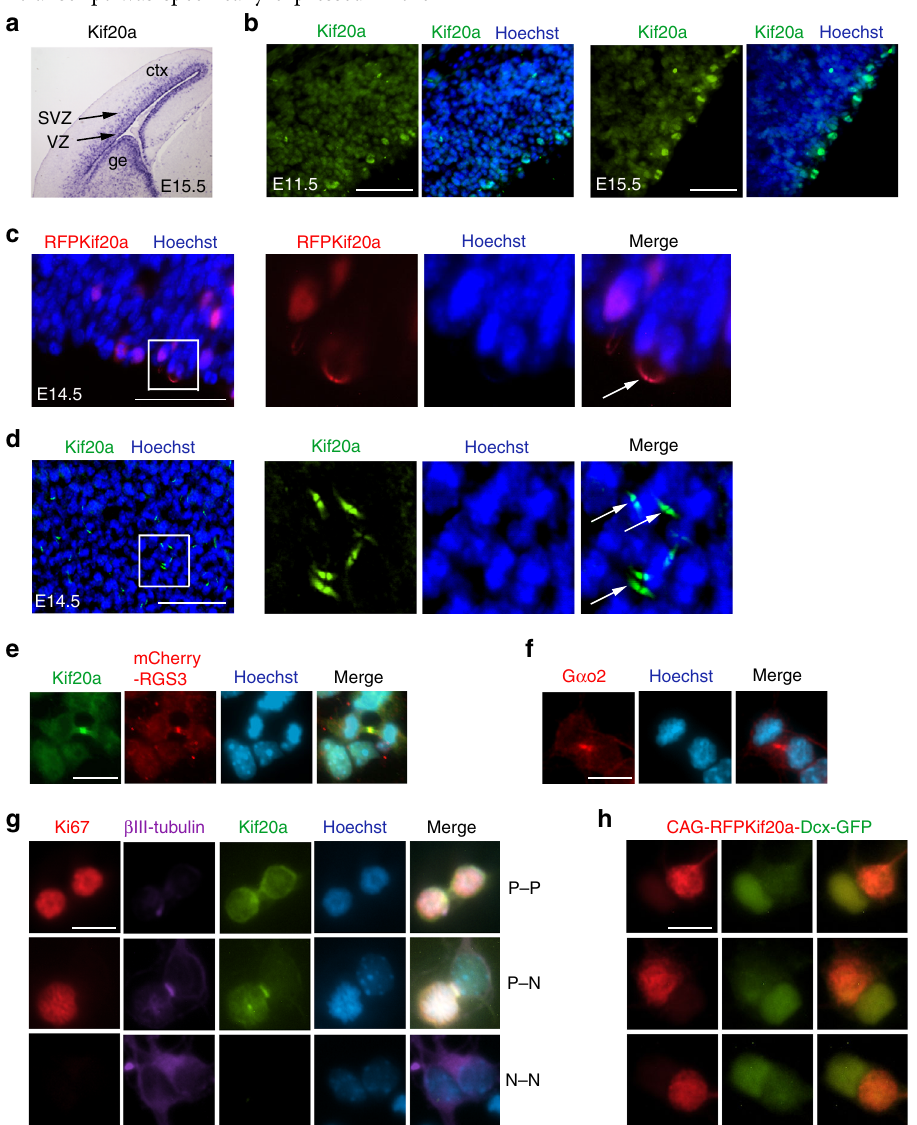
Fig. 1 KIF20A, RGS3, and G α subunit are present in the ICB of mitotic NPCs a RNA in situ hybridization revealed KIF20A mRNA in the germinal zone of the cortex where progenitor cells reside, similar to the transcripts of RGS3 and ephrin-B1 observed previously. ctx: cortex, ge: ganglionic eminence, SVZ: subventricular zone, VZ: ventricular zone. b Anti-KIF20A staining showed that KIF20A protein is more strongly expressed in apically localized mitotic cells. Scale bar represents 100 μ m. c Expression of an RFP-KIF20A fusion protein in the cortex revealed its pattern in the presumptive intercellular bridge of apically dividing cells. Scale bar represents 100 μ m. d En-face view of a whole-mount anti-KIF20A staining with E14.5 cortices revealed that KIF20A was present on the ventricular surface. Scale bar represents 100 μ m. e In dissociated primary cortical progenitor cells with lentiviral expression of a mCherry-tagged RGS3 fusion protein, mCherry-RGS3 could be found in the midbody area of telophase cells with endogenous KIF20A. Scale bar represents 10 μ m. f Immunostaining showed that G α o2 could also be seen present at the midbody region of dividing cortical progenitor cells. Scale bar represents 10 μ m. g Cells from the E14.5 mouse cortices were cultured for 20 h and stained for KIF20A, Ki67, and β -III-tubulin. Paired cells showing symmetric progenitor – progenitor self-renewal (P – P), asymmetric progenitor – neuron (P – N) differentiation, or symmetric neuron-neuron (N – N) differentiation were documented. KIF20A expression was selectively associated with daughter progenitor cells. Scale bar represents 10 μ m. h Cortical cells electroporated with a plasmid carrying a CAG promoter-RFP- KIF20A cassette and a DCX promoter-GFP cassette were analyzed after 20 h in culture. In paired cells (showing three examples) with asymmetrical division (with daughter neurons marked by GFP), RFP-KIF20A, and GFP showed complementary patterns of expression. Scale bar represents 10 μ